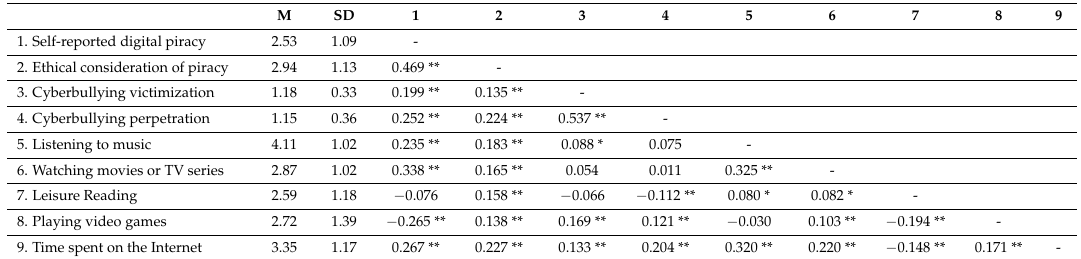
Table 1. Correlations between the self-reported digital piracy, leisure activities, time spent on the Internet, and cyberbullying